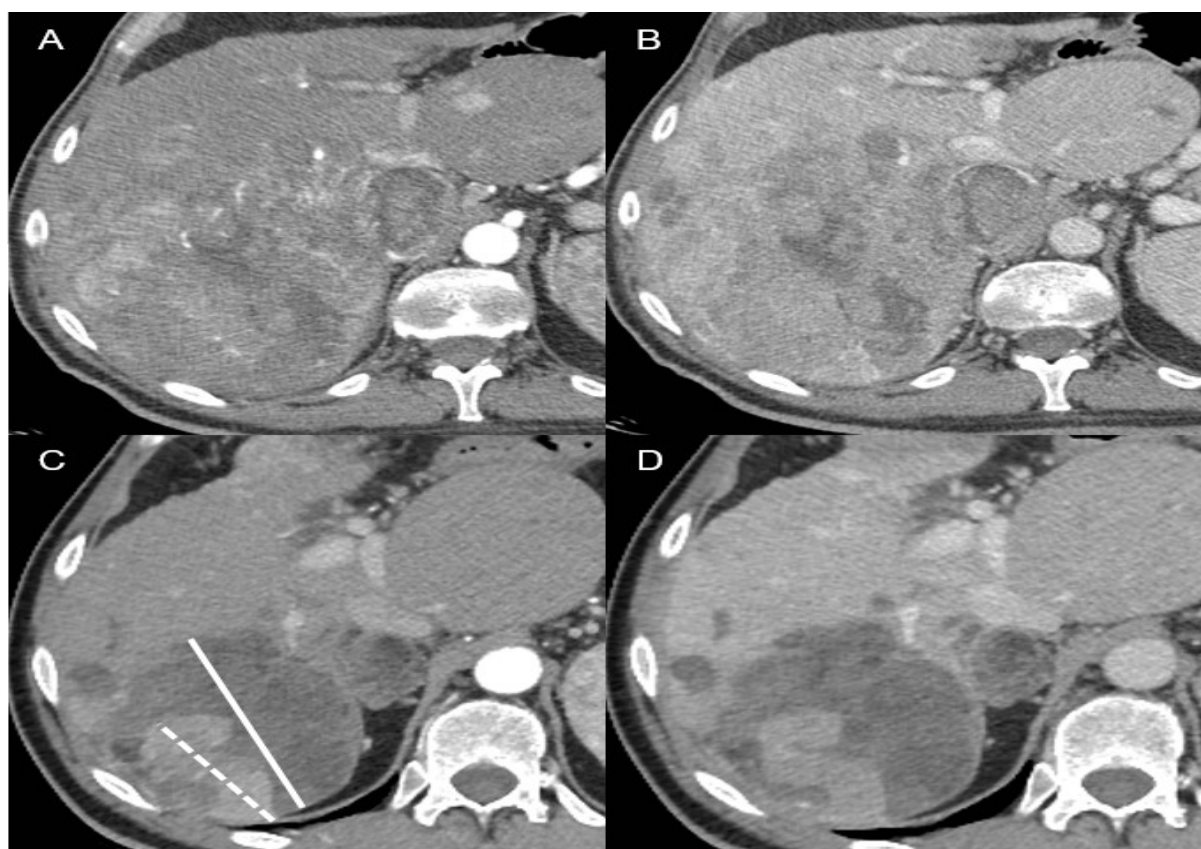
Figure 3. A 61-year-old man with infiltrative hepatocellular carcinoma and tumour thrombosis of the inferior vena cava: On baseline contrast-enhanced CT (( A ), arterial phase; ( B ), portal venous phase), the largest tumour diameter measures 12.8 cm. CT follow-up (( C ), arterial phase; ( D ), portal venous phase) after three months of atezolizumab–bevacizumab demonstrates a decrease in the size of the lesion, with a total tumour diameter of 10.8 cm (continuous line), consistent with stable disease according to the RECIST 1.1 criteria, but with a residual internal enhancing component of 6.1 cm (dashed line), consistent with a partial response according to the mRECIST criteria.